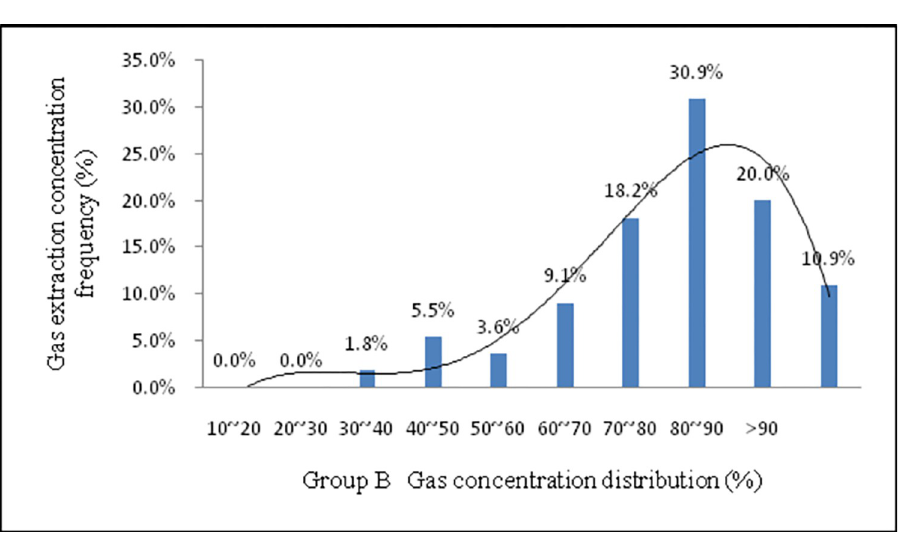
Fig 17. Gas concentration frequency distribution histogram Group B.